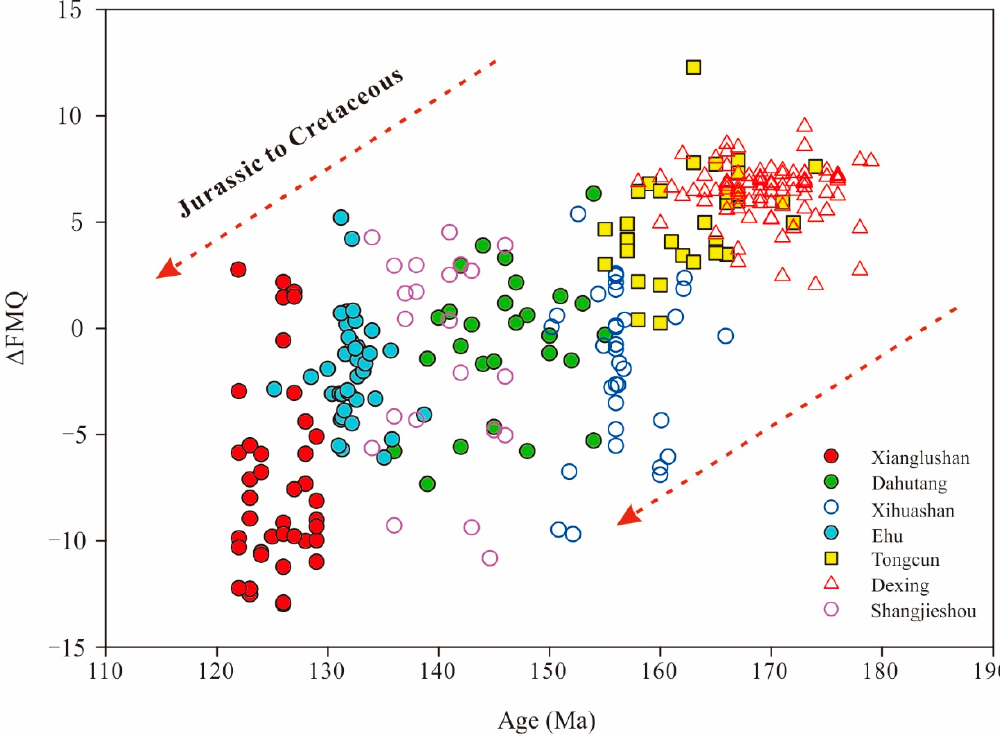
Table 4. Statistics of oxygen fugacity data for Yanshanian granites in Jiangxi Province.